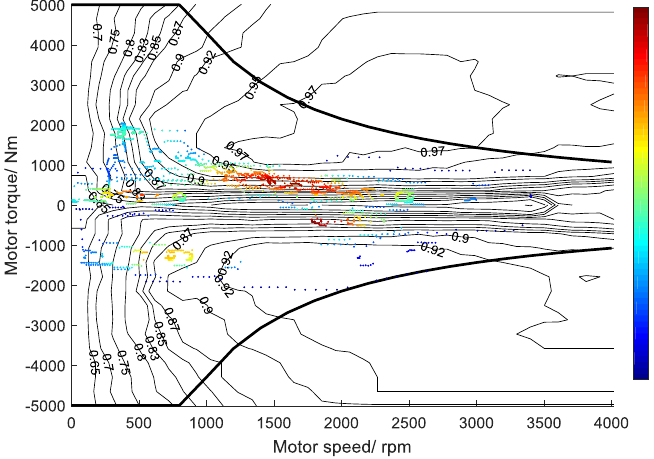
Figure 17. Operating point distribution on the motor efficiency map of the EDT with a single speed transmission.